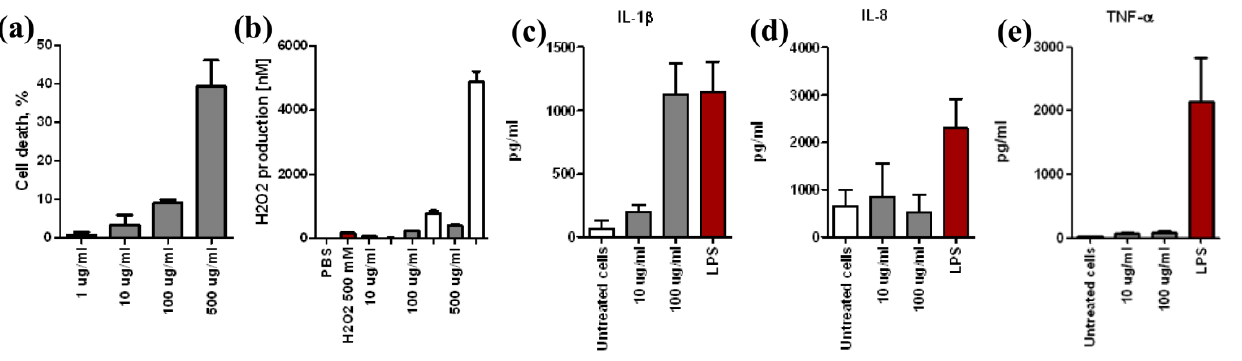
Figure 6. Nanodiamond Molto particles induce pro-inflammatory response. ( a ) Cell death of macrophages induced by 1, 10, 100 and 500 μg/mL of NDs; ( b ) PBS, H control with cells, Acellular (open bars), and cellular (filled bars) ROS production induced by 10, 100 and 500 μg/mL of NDs; ( c ) IL-1β; ( d ) IL-8 and ( e ) TNF-α cytokine secretion from macrophages induced by 10 and 100 μg/mL of NDs. Error bars represent ±SD of two ( a , c – e ) or three ( b ) independent